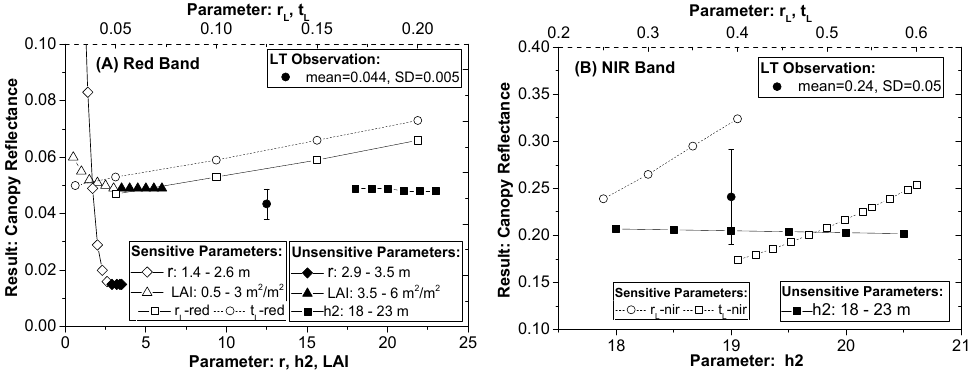
Figure 5. Single order sensitivity analysis of the impacts of sensitive parameters on GORT model outputs for the red band ( A ) and the NIR band ( B ). Only one of the model sensitive parameters was adjusted each time to study variations in the model output spectral signatures.